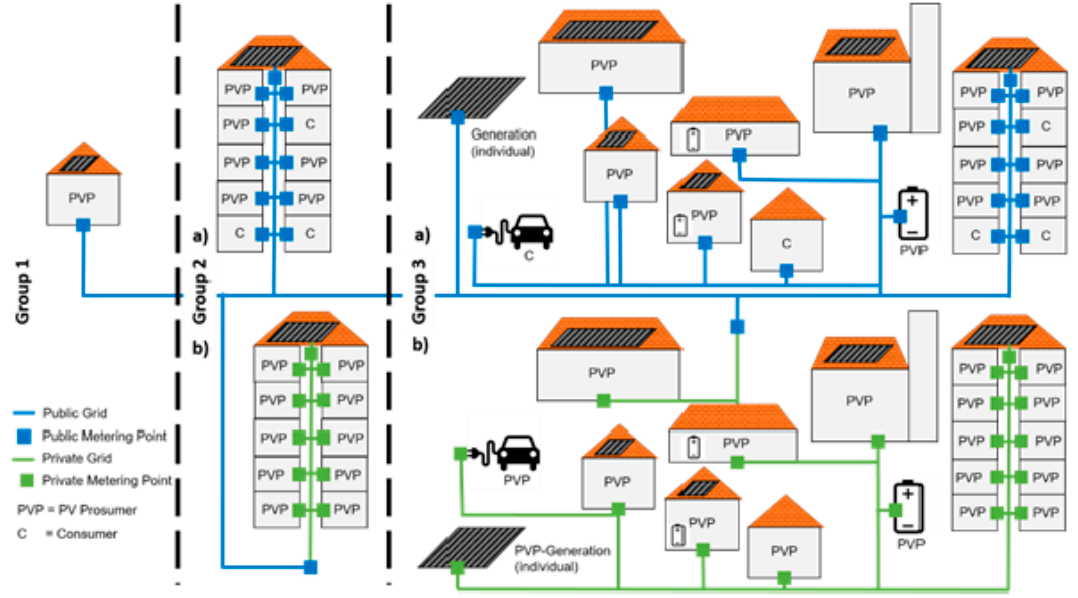
Figure 1. Classification of integration concepts [7].